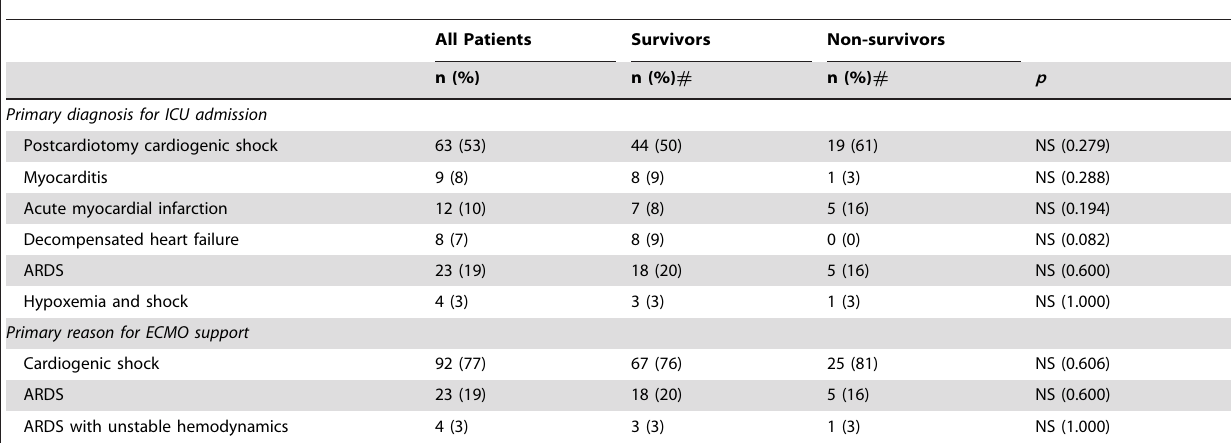
Table 2. Primary diagnosis for intensive care unit (ICU) admission and extracorporeal membrane oxygenation (ECMO) support.